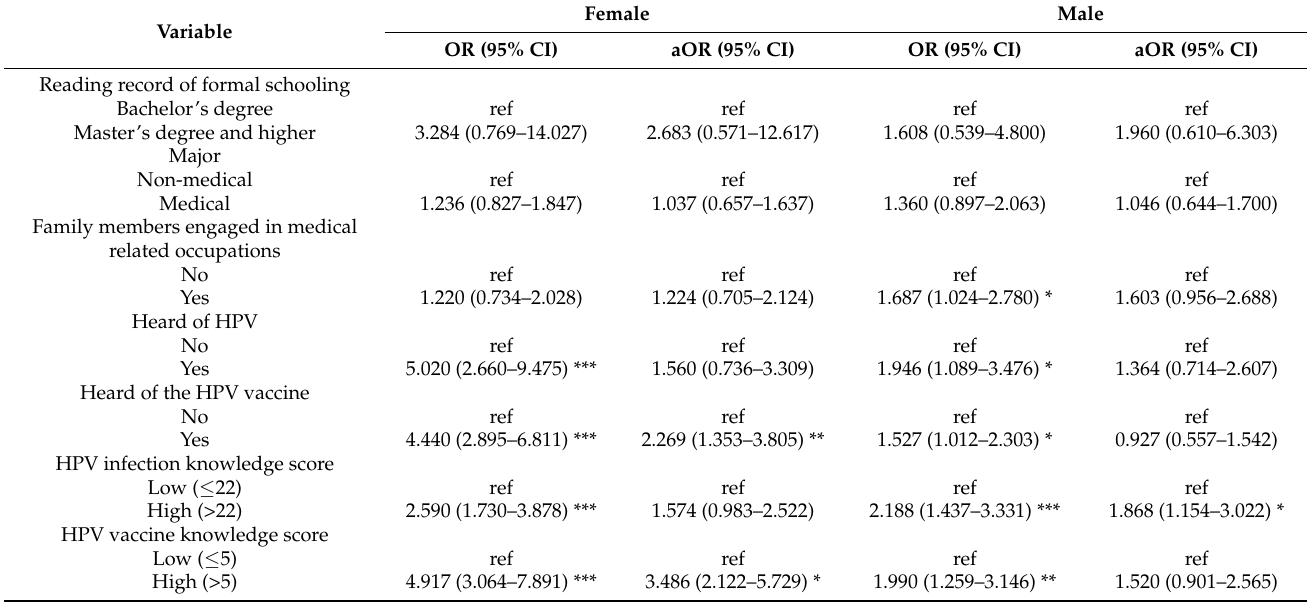
Table 4. Factors associated with the willingness to receive HPV vaccination by